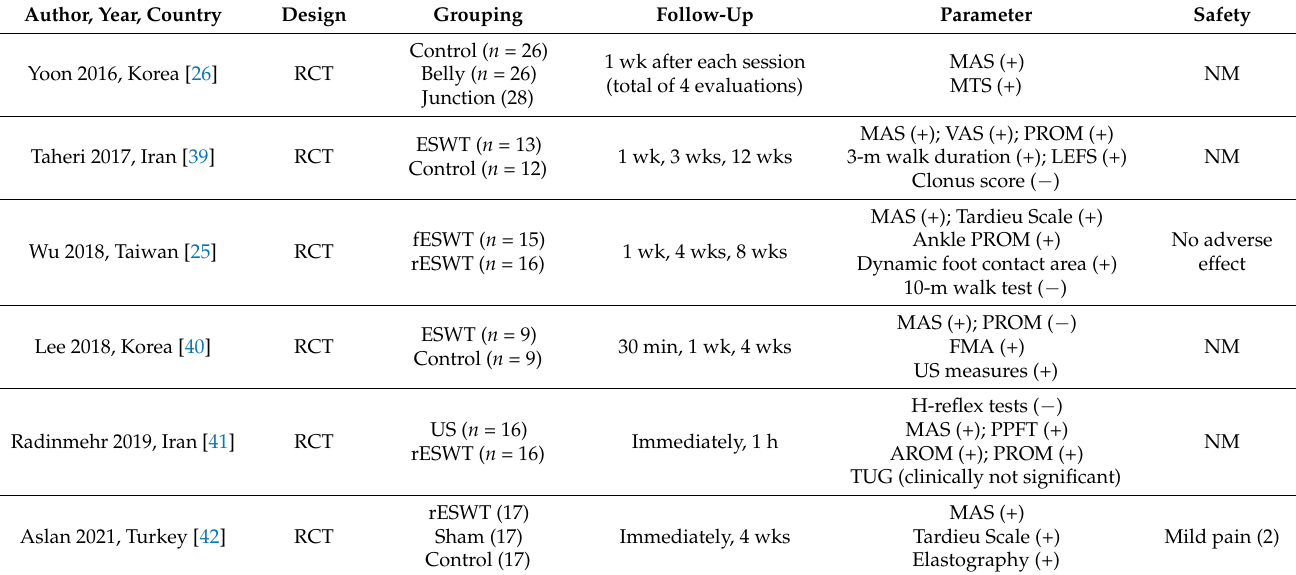
Table 3. Lower limb studies-design and outcome